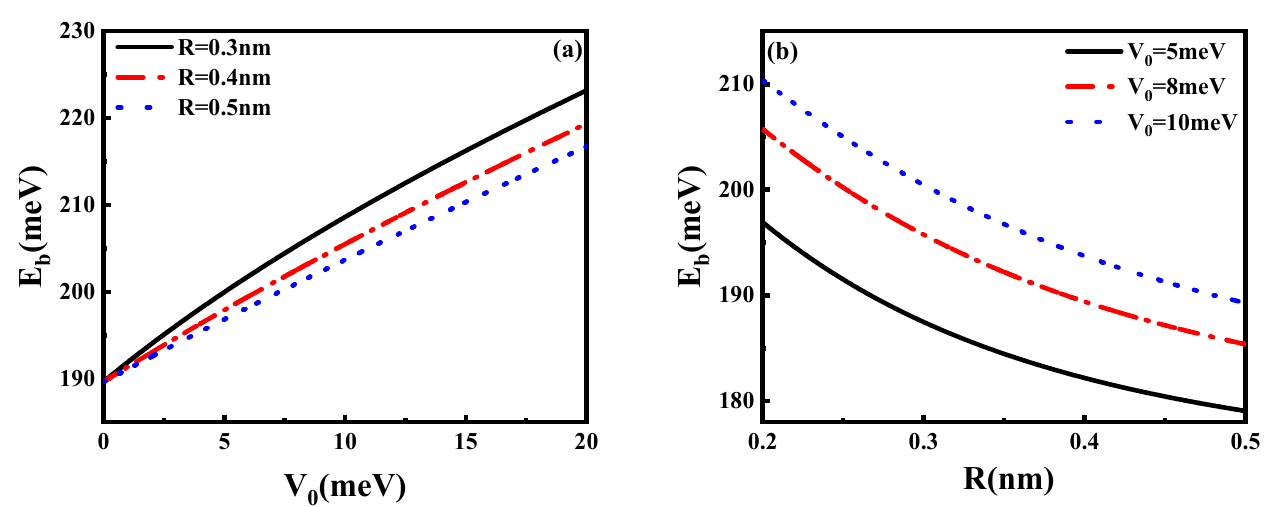
Figure 1. Ground-state energy E 0 versus ( a ) AGCP barrier height V 0 and ( b ) AGCP range R.